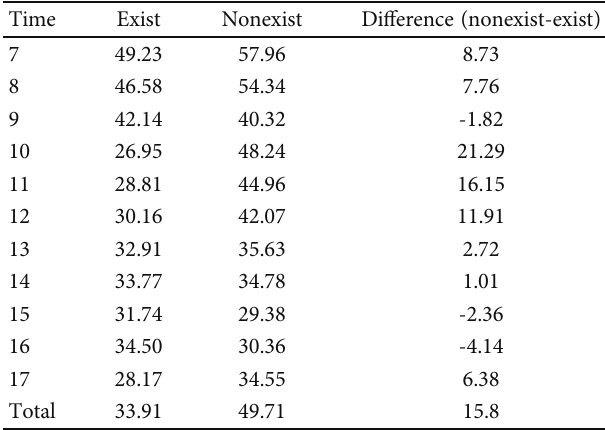
Table 7: Mean waiting time depending on whether there is a vacant vehicle that exists or not